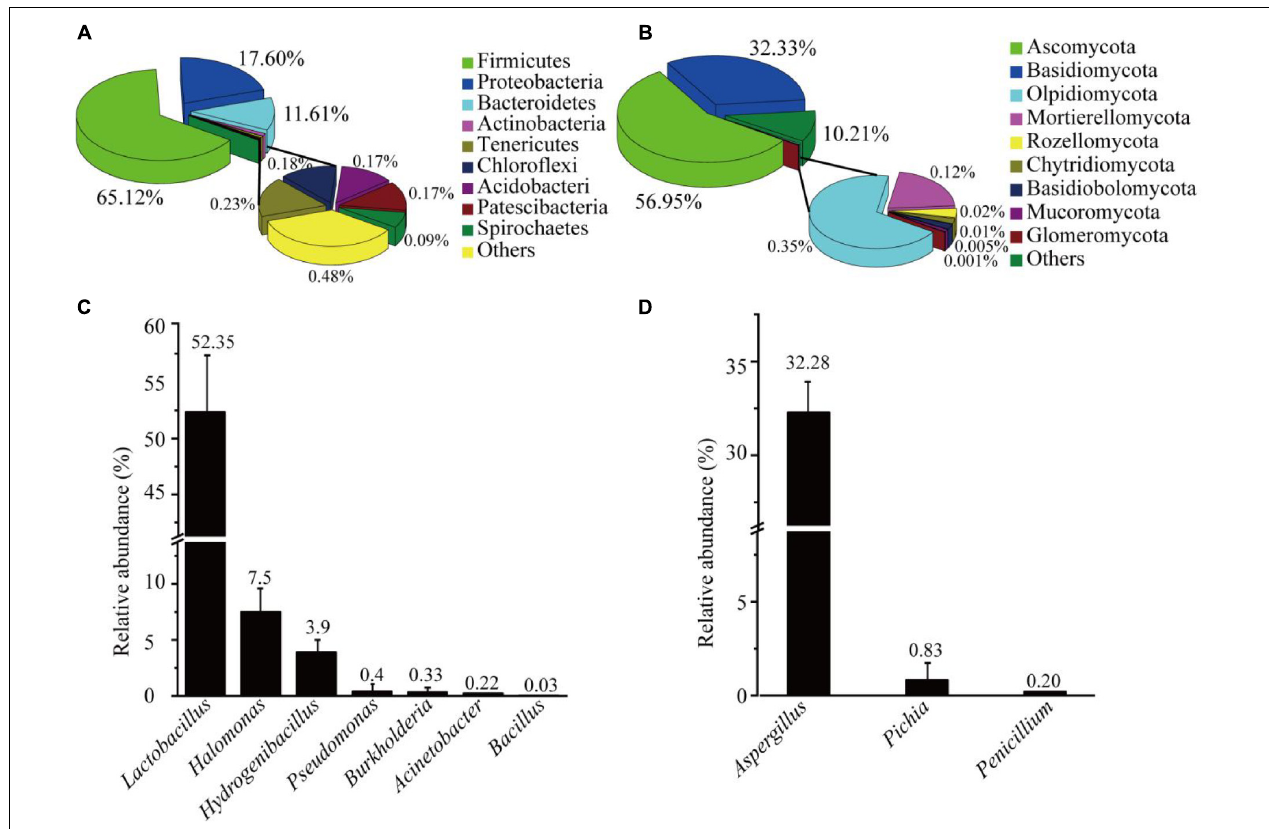
FIGURE 1 | Microbial community structure of AJ: (A) bacterial community at the phylum level; (B) fungal community at the phylum level; (C) relative abundance of bacteria with potential biological control functions; (D) relative abundance of fungi with potential biological control functions. Values in the bar plot are expressed asmean ± standard deviation ( n =